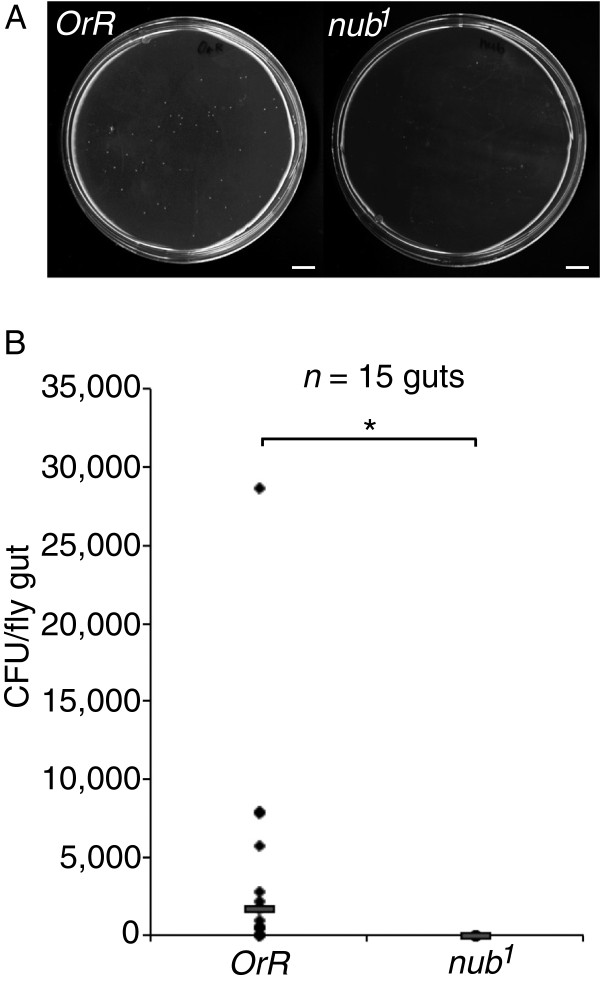
Homogenates of nub1 mutants contain a reduced number of platable bacteria. (A) Homogenates of dissected nub1 guts, spread out on standard lysogeny broth agar plates, contain a significantly reduced number of platable colony forming units compared to diluted homogenates from guts of OrR controls. (B) A total of 15 individuals guts per fly strain (n) were assayed and the median of the experiment is shown in the graph as a horizontal bar. Statistical significance was calculated using unpaired t-test, *P <0.05. Scale bar in A = 1 cm. CFU, colony forming units.